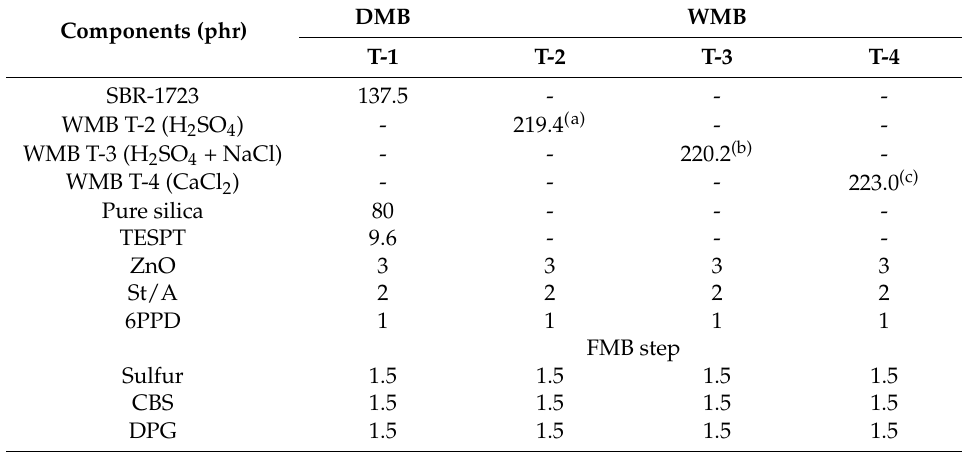
Table 2. Formulation of wet masterbatch (WMB) compounds and dry masterbatch (DMB) compound according to the coagulant